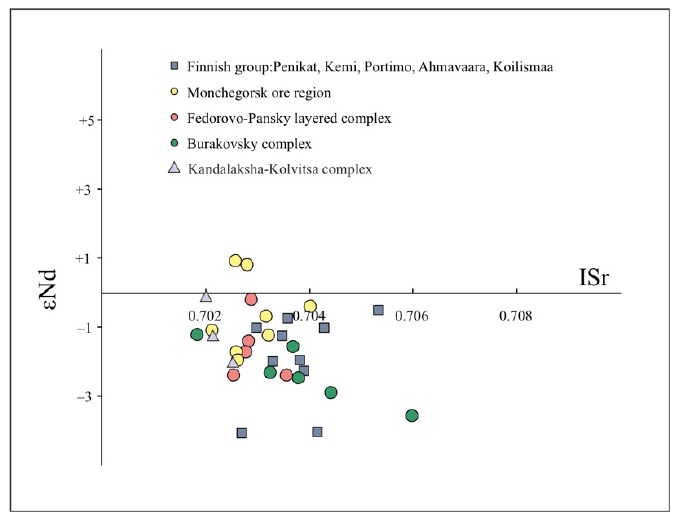
Figure 11. Variations of ε Nd vs. ISr in rocks of Paleoproterozoic layered intrusions in the Fennoscandian Shield. Data for Finnish group, Burakovsky and Kandalaksha-Kolvitsa complexes from [13,16,17,67].